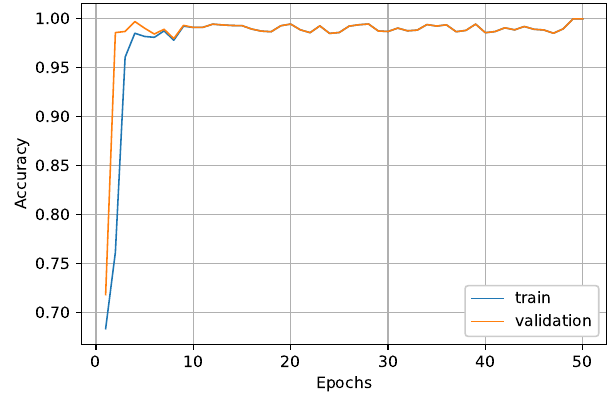
Figure 11. Autoencoder network training